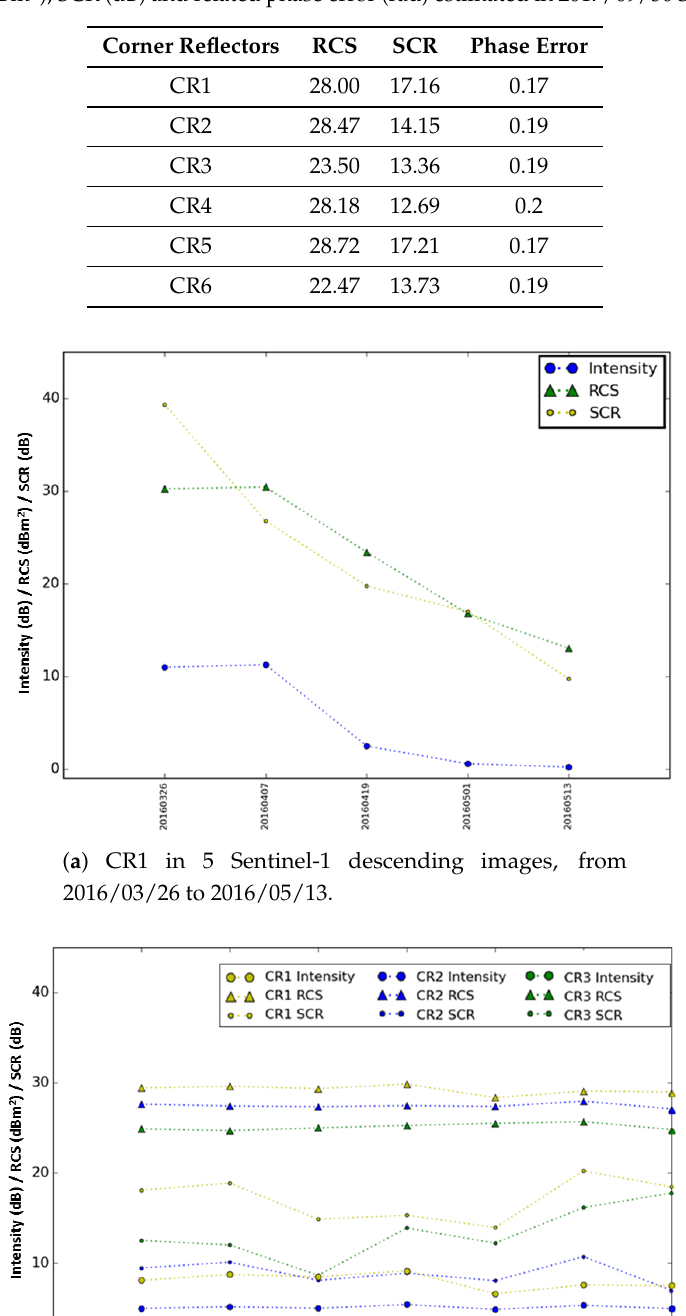
Table 2. RCS (dBm 2 ), SCR (dB) and related phase error (rad) estimated in 2017/09/30 Sentinel-1 image.